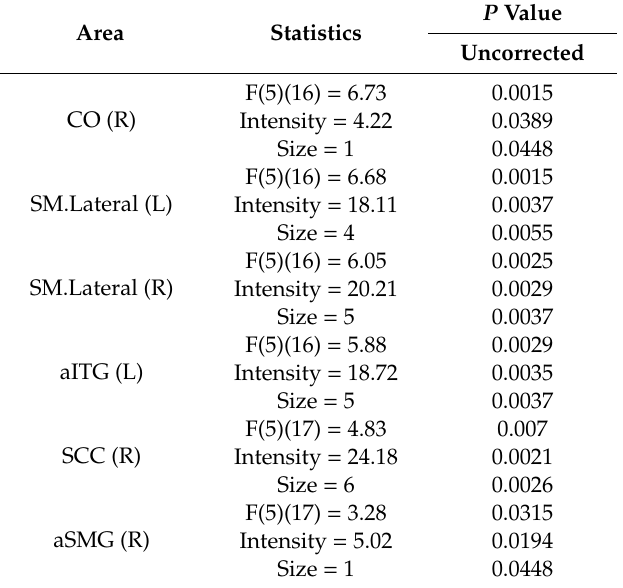
Table 2. Mouth > Nose contrast connected regions included ROI that were more significantly connected at a 0.05 one-sided (positive) uncorrected- P